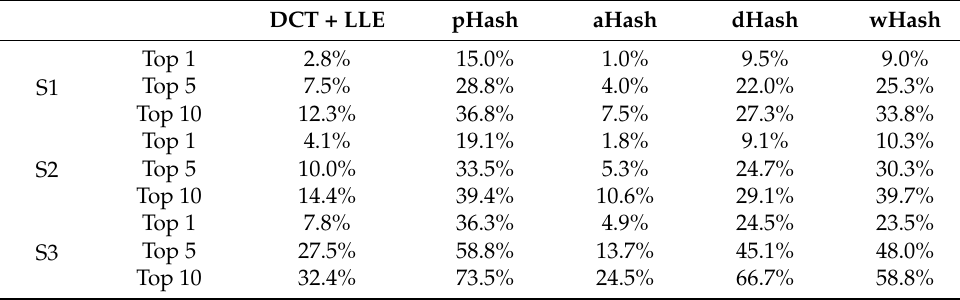
Table A6. Correct matches results for database vs. TS2 comparison—64